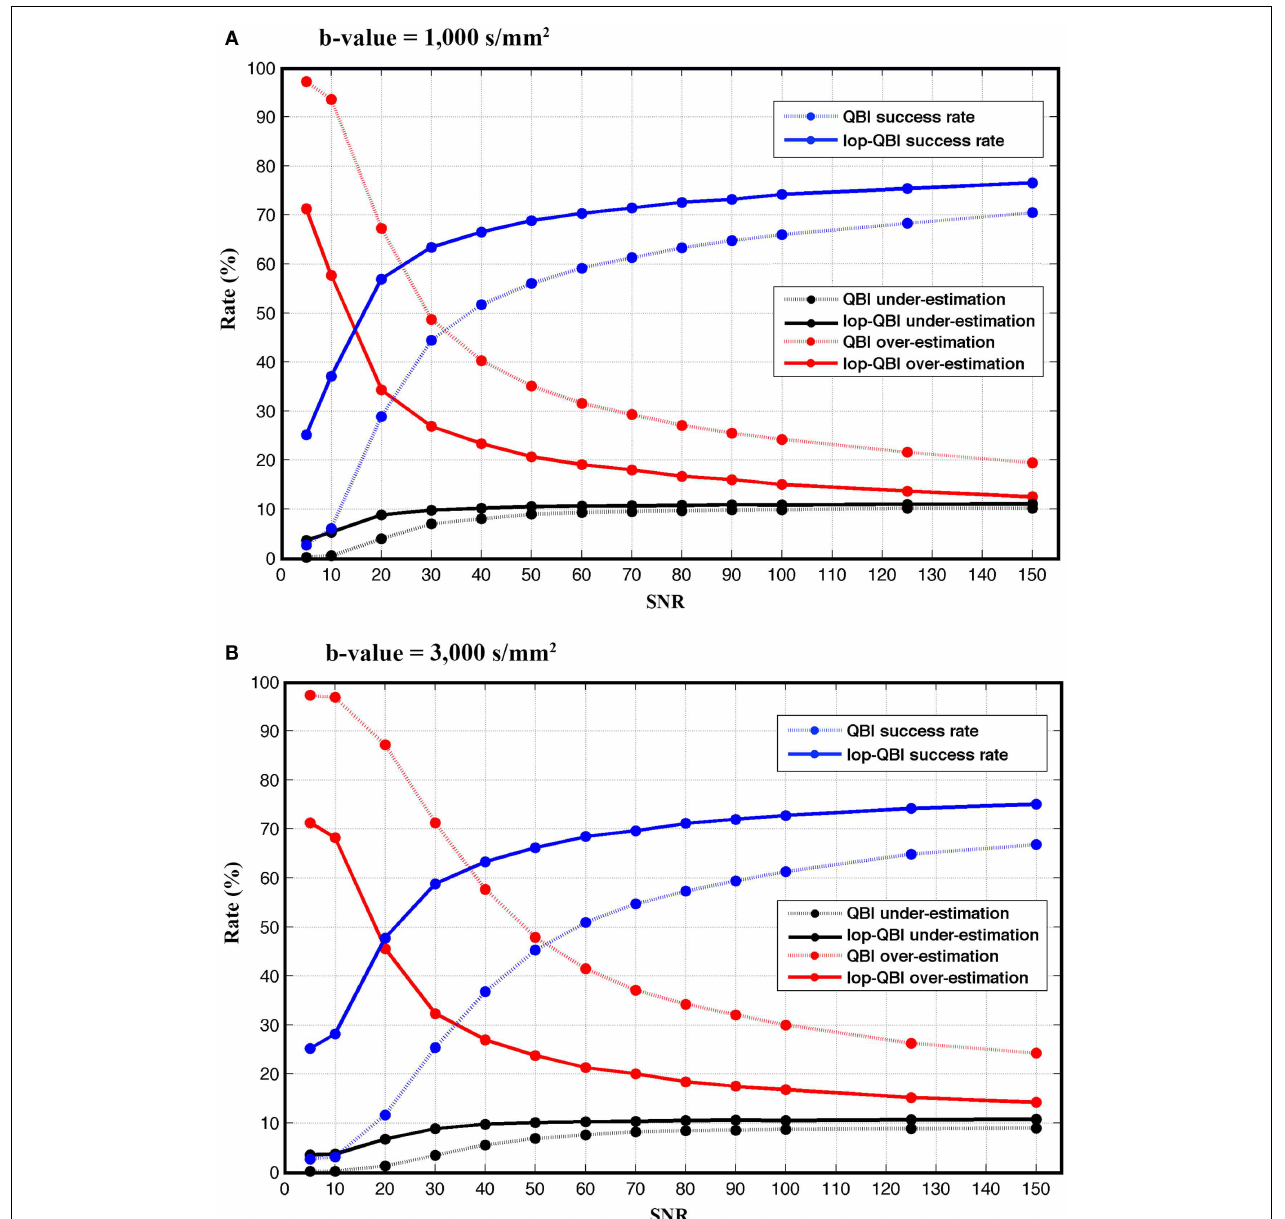
FIGURE 5 | Success, over-estimation, and under-estimation rates (see Method), measured from raw-DWI (dotted lines) and lop-DWI, across different SNRs . (A) is the results from simulation with b -value = 1,000s/mm 2 and (B) with b -value = 3,000s/mm 2 .